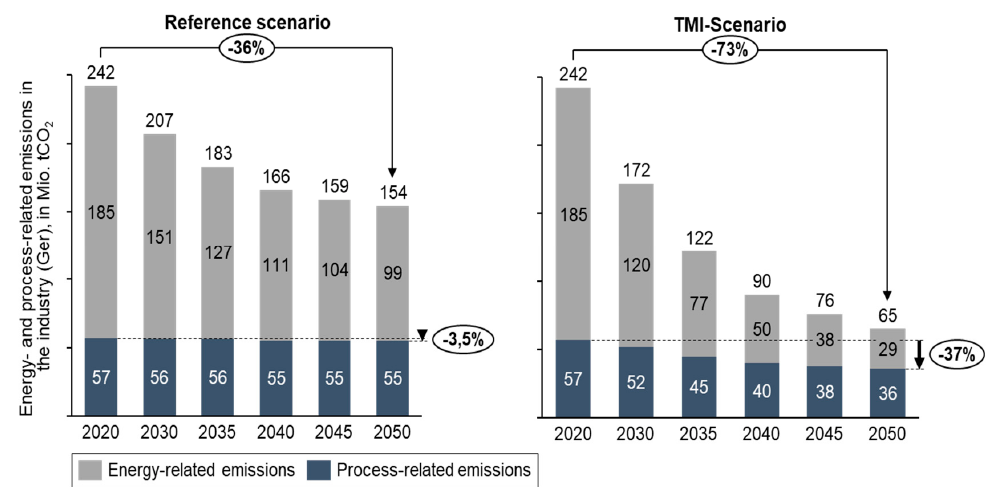
Figure A4. Energy and process-related emissions in the Reference (left) and TMI scenarios between 2020 and 2050.